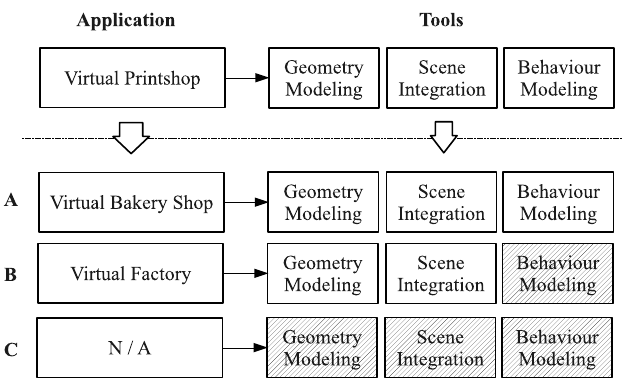
Fig. 7. Three additional companies were involved to generalize the case study results, including a product design agency (A), a machine design multinational (B) and a truck design multinational (C). Etched areas depict tool chain components that were not included in the tool chain of the particular